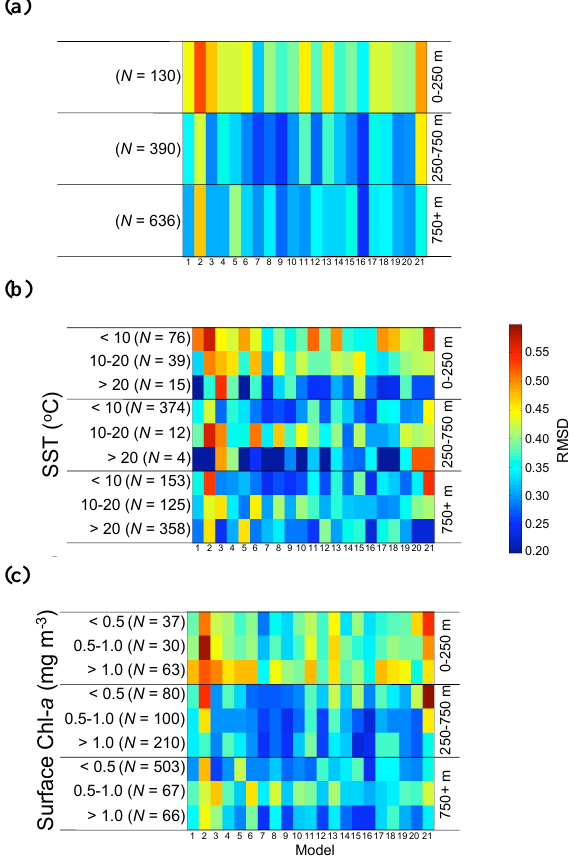
Fig. 10. Model skill (RMSD) for each model at (a) three depth ranges, (b) three SST ranges at each depth range, and (c) three sur- face Chl- a ranges at each depth range. The station sample size ( N) for each depth range and SST/surface Chl- a range is also listed.